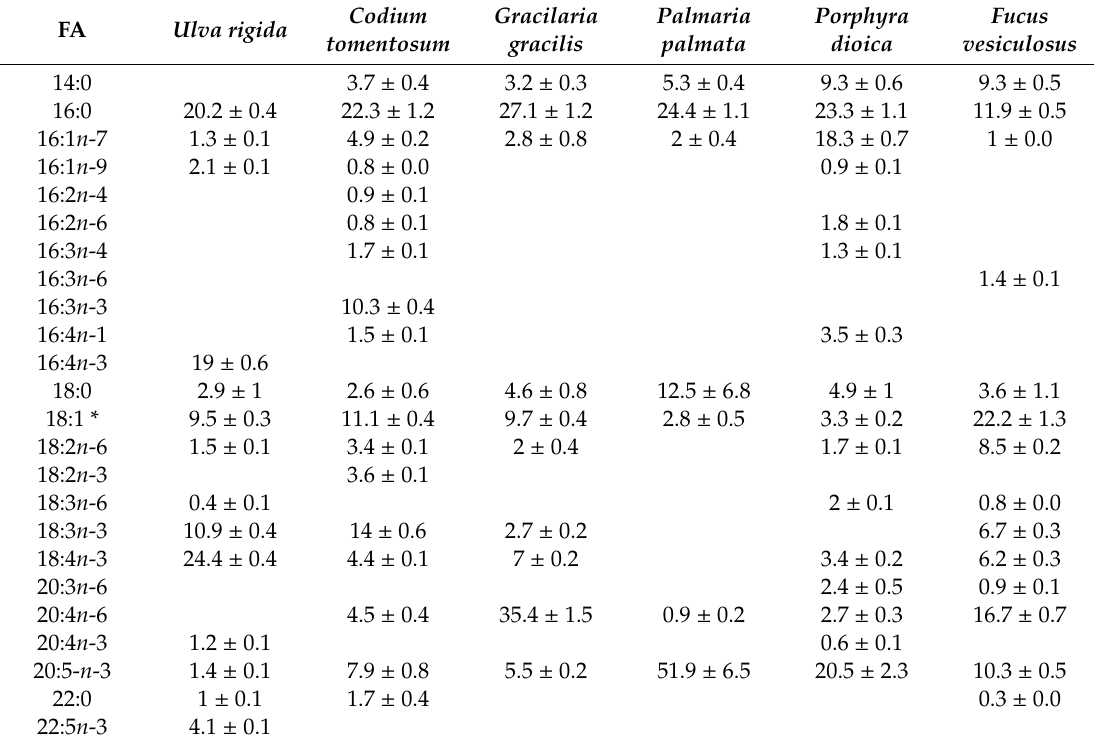
Table 1. Fatty acids (FA) profile of green Ulva rigida and Codium tomentosum ; red Gracilaria gracilis, Palmaria palmata and Porphyra dioica ; and brown Fucus vesiculosus macroalgae. Abundances are expressed in relative abundance (%) and values are means of five samples ( n = 5) ± standard deviation.